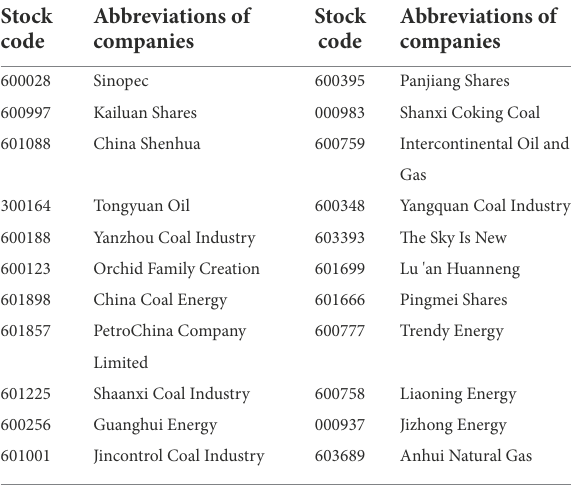
TABLE 2 Basic information of sample companies, statistics, stock codes, company abbreviations. Stock code